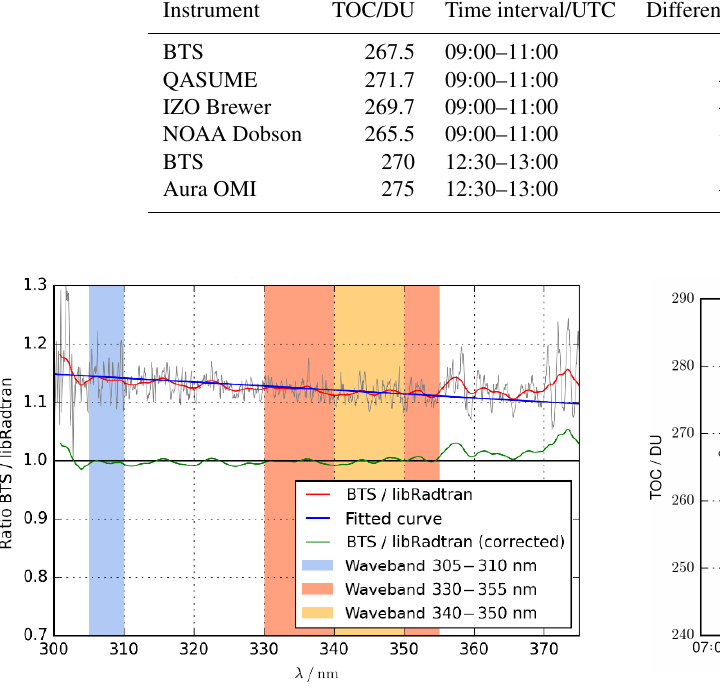
Figure 8. Total ozone column (TOC) derived by the direct solar measurements of the BTS in comparison to other instruments. The measurements have been conducted during the ATMOZ intercom- parison campaign on 20 September 2016. The TOC values stated in the legend for each ground-based instrument have been derived by averaging the values between 09:00 and 11:00UTC (blue area). Grey dots symbolise the BTS TOC measurements captured every 8s; only integer values are apparent due to the 1DU resolution of the lookup